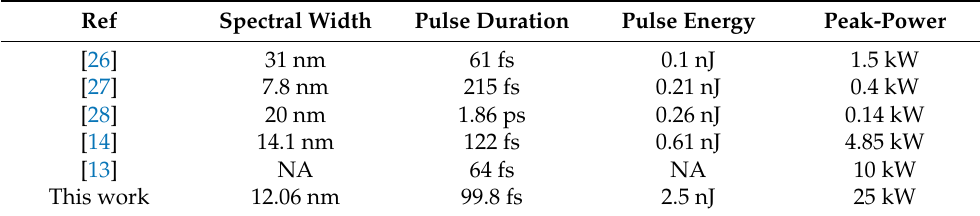
Table 1. Comparison of direct output pulses of figure-of-9 mode-locked fiber